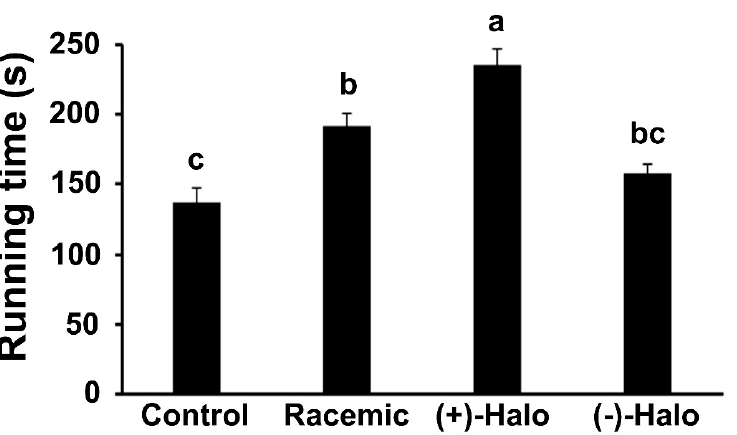
Figure 2. Effect of the racemic halofuginone (Racemic), (+)-halofuginone enantiomer [(+)-Halo] and ( − )-halofuginone enantiomer [( − )-Halo] on the motor coordination of mdx mice at 14 weeks of age. Data are presented as mean + SEM ( n = 4–6/group). Bars with different letters indicate significant difference between groups ( p <